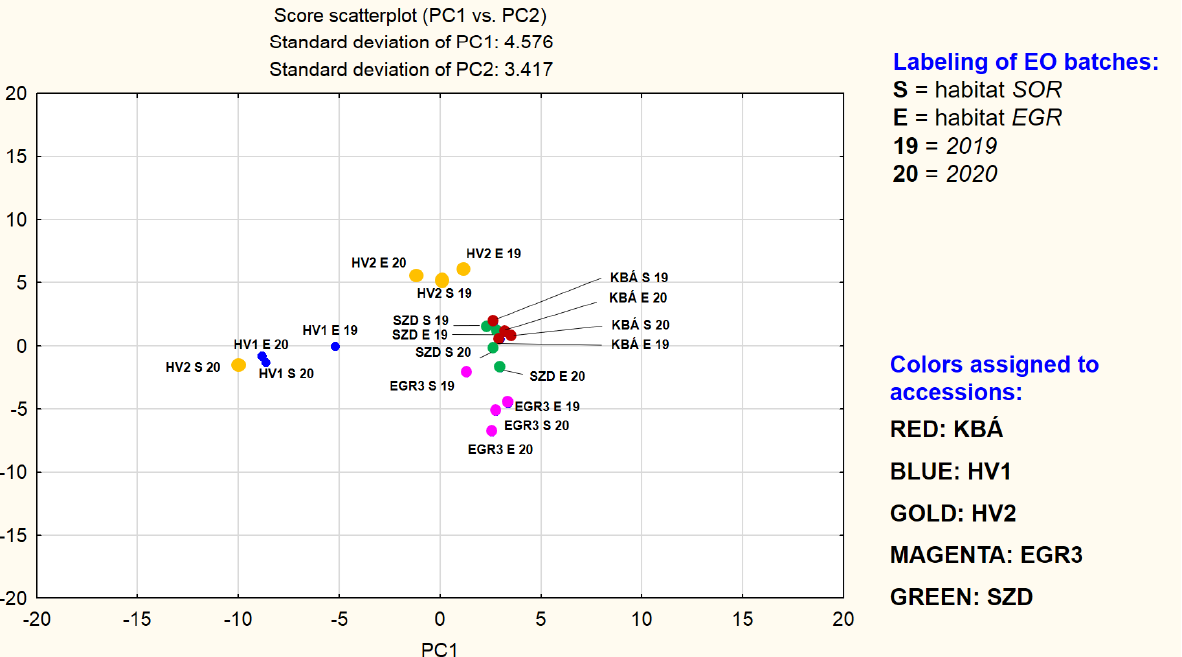
Figure 3. Scatterplot of PC1 vs. PC3. Figure 2 may demonstrate a grouping primarily based on the mevalonate pathway branches of the main components. The other plot may modify this picture, showing a grouping which depends both on compound type (limonene-2-oxo, limonene-3-oxo, and γ -terpinene derivatives) and the accession, except for HV2 . In the plane of PC1 vs. PC2